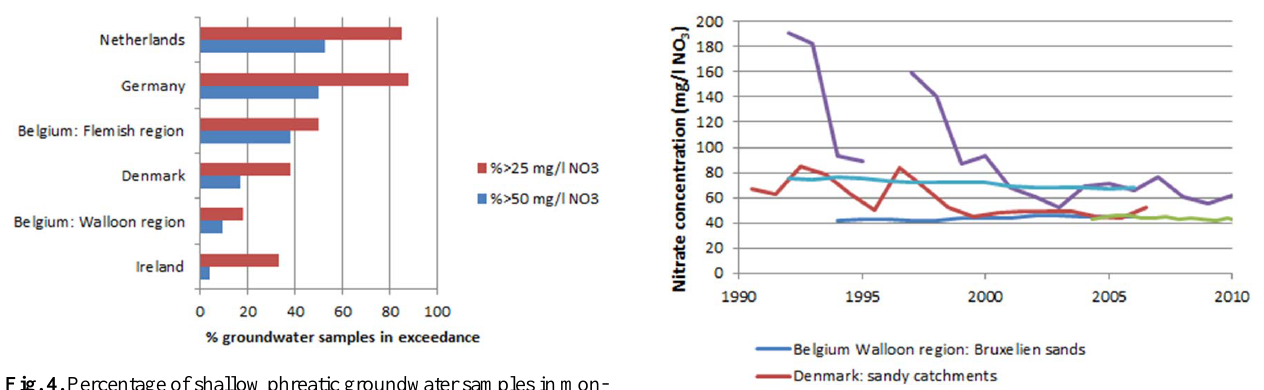
Fig. 4. Percentage of shallow phreatic groundwater samples in mon- Figure 4. Percentage of shallow phreatic groundwater samples in monitoring programs for the 2 itoring programs for the Nitrates Directive for the 3rd reporting pe- Nitrates Directive for the 3 rd reporting period (2004-2007) exceeding 25 or 50 mgNO 3 /l. 3 riod (2004–2007) exceeding 25 or 50mgNO 3 L − 1 .